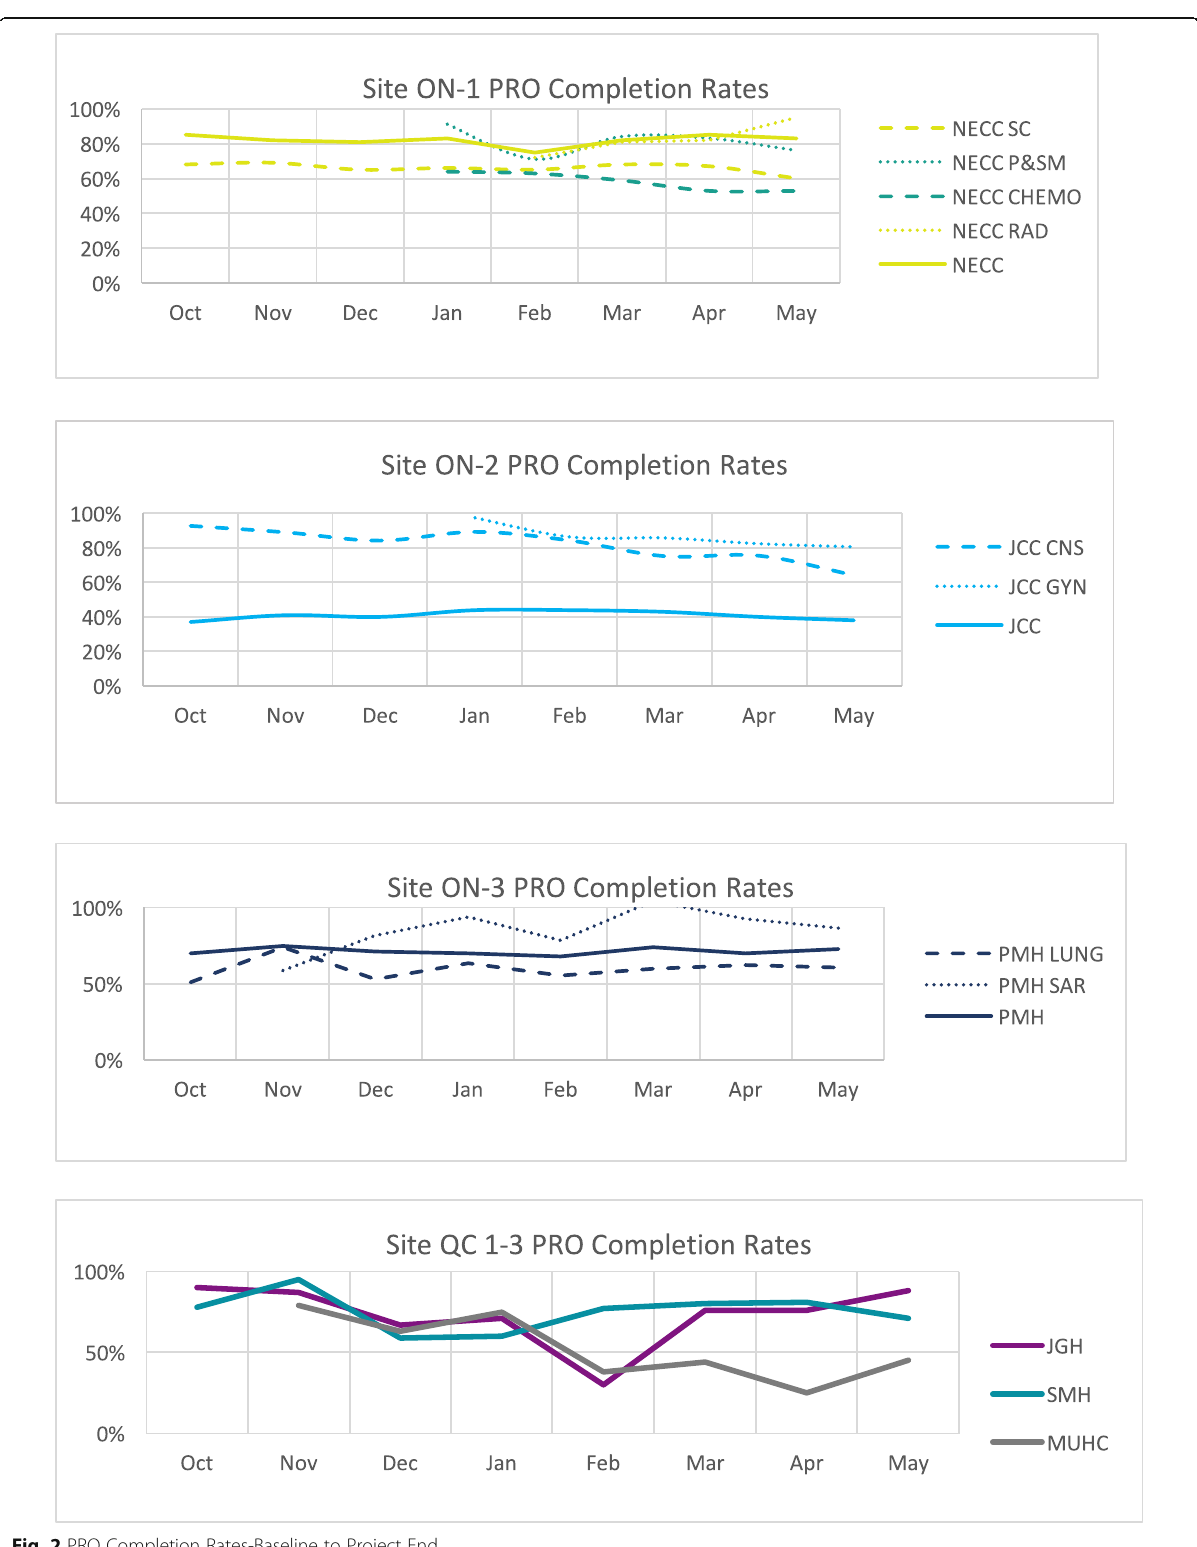
Fig. 2 PRO Completion Rates-Baseline to Project